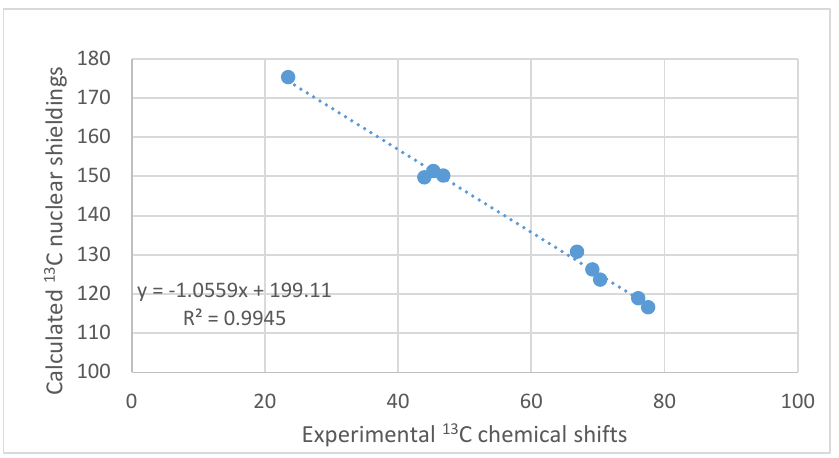
Figure 11. Plot of calculated 13 C nuclear shieldings vs. experimental chemical shifts of anhydrogossypol (see Figure 10). 13 C NMR data from Ref. [45].